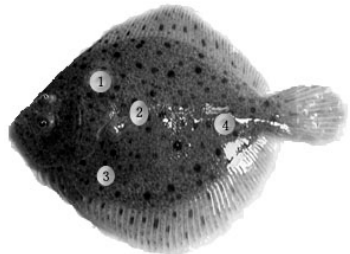
Figure 4. Sampling sites on the back side of turbot. Mark 1 was in the middle of the leading edge of dorsal fin and the trailing edge of operculum; Mark 2 was around the front end of lateral line; Mark 3 was at the place of one fourth from anus to point 2; Mark 4 was at the two thirds of lateral line.